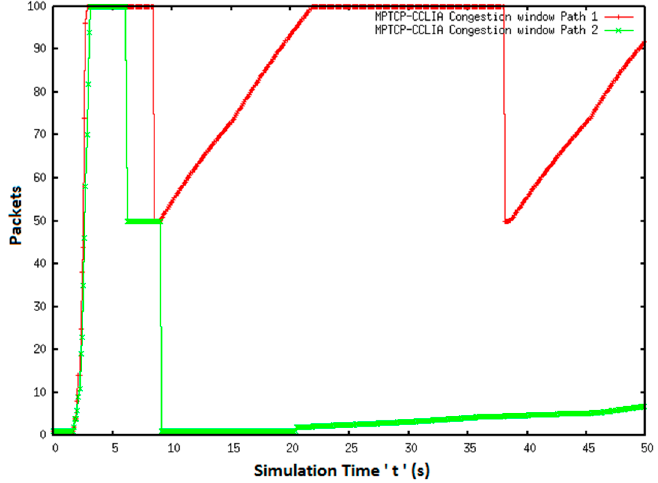
Figure 15. Congestion window plots of MPTCP-CC-LIA for Setup 3.